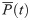
Four local patches are sampled to show their patch size time series (unit: pixels) N, change in patch size over time (unit: pixels) C, boxplots of C and PSD of pixel intensity series. The pixel intensity series is P¯(t).